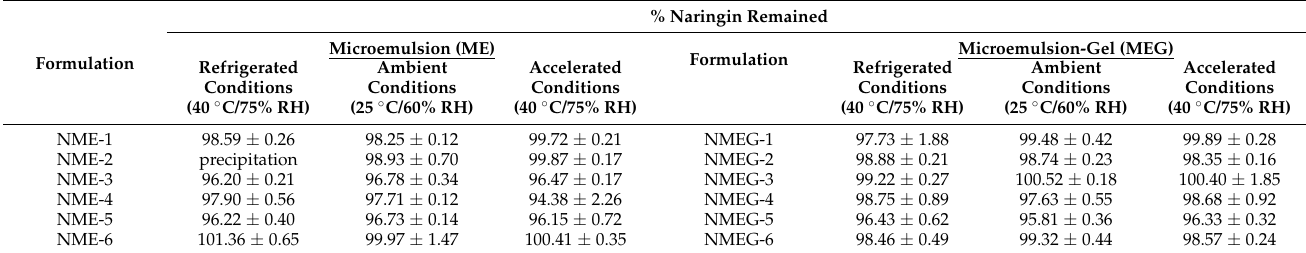
Table 5. Chemical stability data of naringin-loaded microemulsion and microemulsion gel formula- tions after 1 month storage at different storage conditions. Data represent the mean ± SD (n =